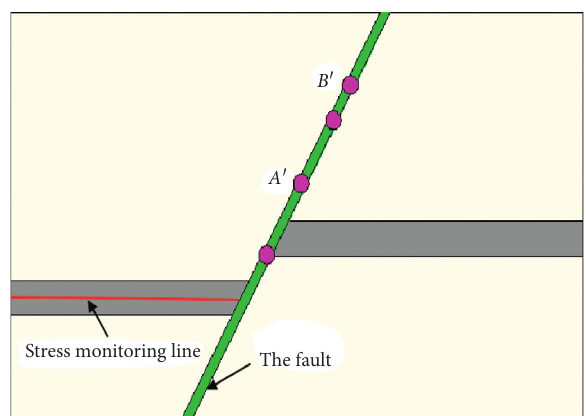
Figure 10: Schematic diagram of the numerical simulation monitoring point